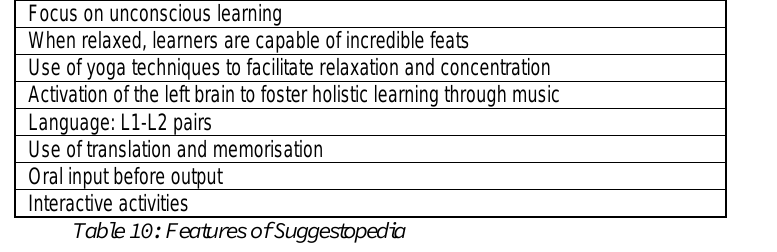
Table 10: Features of Suggestopedia DISCUSSION